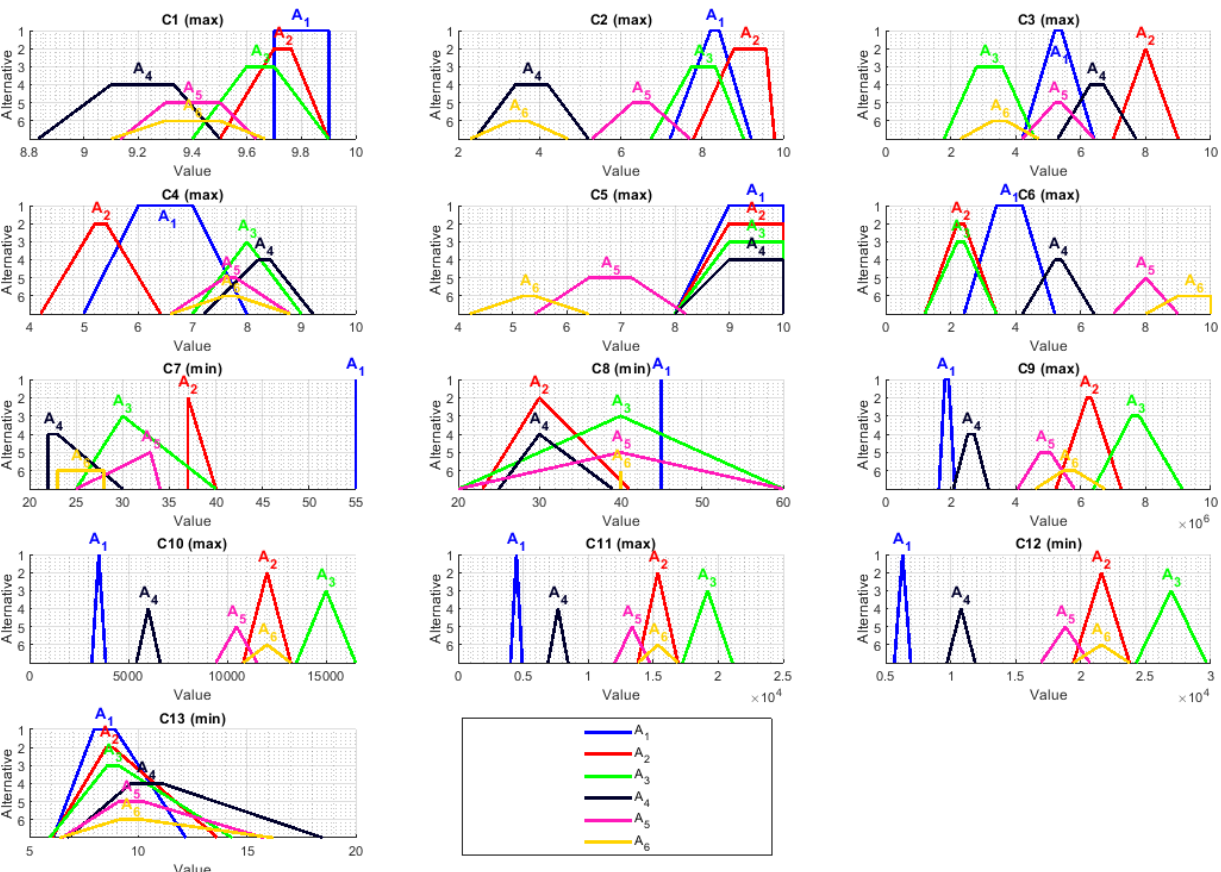
Figure 4. Aggregated fuzzy assessments of alternatives. Table 9. Ranking of offshore wind farms planned in Poland in the coming